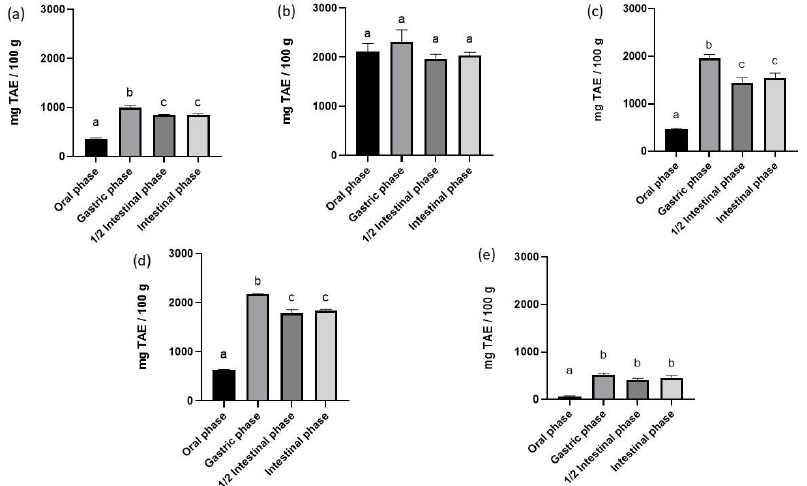
Figure 1. Total phenolic content (TPC) of in vitro digestion. TAE: Tannic acid equivalent. Data are presented as mean ± standard error of mean (SEM). ( n = 3). Different superscript letters in columns indicate significant different data ( p < 0.05). ( a ) hempseeds; ( b ) flowers; ( c ) hempseed protein extract; ( d ) soy protein extract; and ( e ) flaxseeds. End of oral phase, end of gastric phase, 1 ⁄ 2 intestinal phase, and end of intestinal phase.